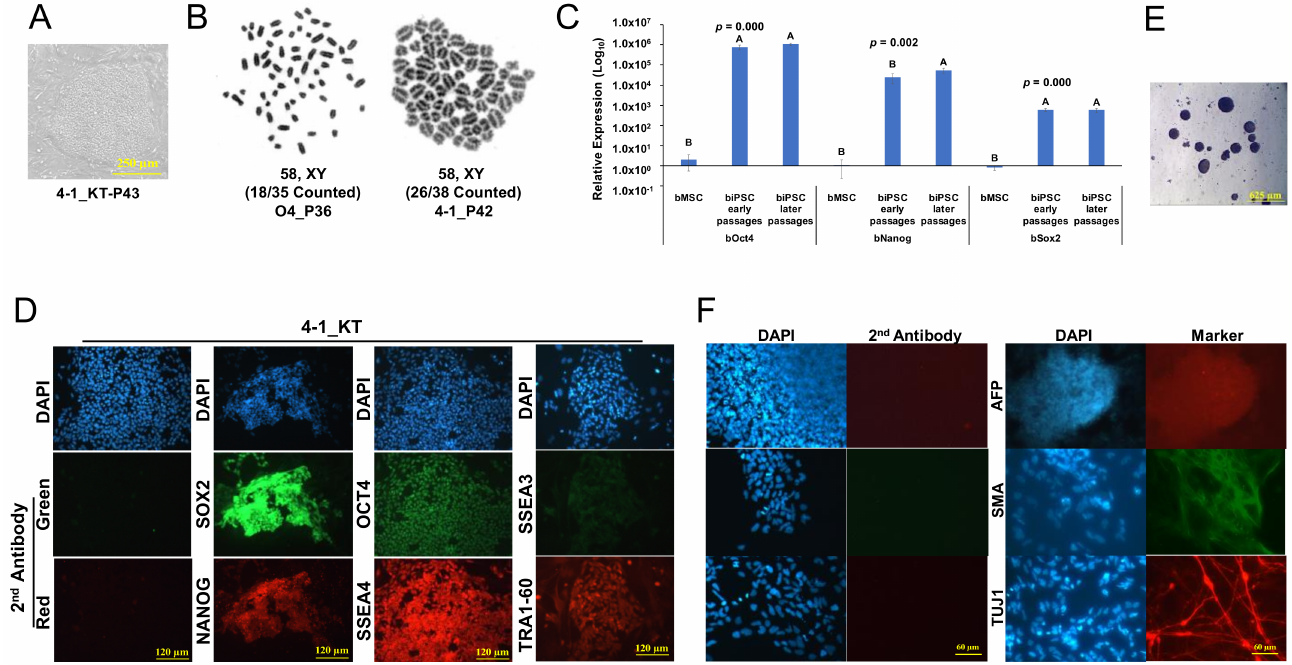
Figure 2. Characterization of primed-like bovine iPSCs. ( A ): Flat colony morphology of 4-1 in KT medium. Bar = 250 µ m. ( B ): Karyotype for O4 and 4-1 biPSC lines at passage 36 and 42, respectively. ( C ): qRT-PCR for endogenous expression of pluripotent genes in four lines of biPSCs at early passages (4-1 at P17, 4-6 at P17, 3-2 at P10) and later passages (4-1 at P43, 4-6 at P25, 3-2 at P29, O4 at P40). Bar = mean ± sd, n = 4. One way–ANOVA with Tukey’s post hoc multiple comparison test was used for data analysis. ( D ): Representative immunostaining images of biPSCs in KT medium for OCT4, NANOG, SOX2, SSEA3, SSEA4, TRA-1-60. Bar = 120 µ m. ( E ): EBs formed from 4-1_KT, bar = 625 µ m. ( F ): Immunostaining of differentiated cells for the three-germ layer markers (AFP for endoderm, SMA for mesoderm, and TUJ1 for ectoderm) after passaging of the EBs. bar = 120 µ